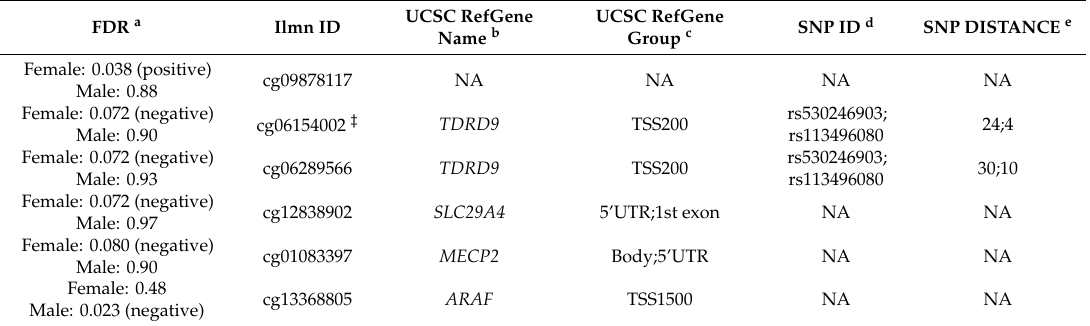
Table 4. Genes in cord tissue showing altered methylation degrees in relation to maternal PCB exposure according to correlation